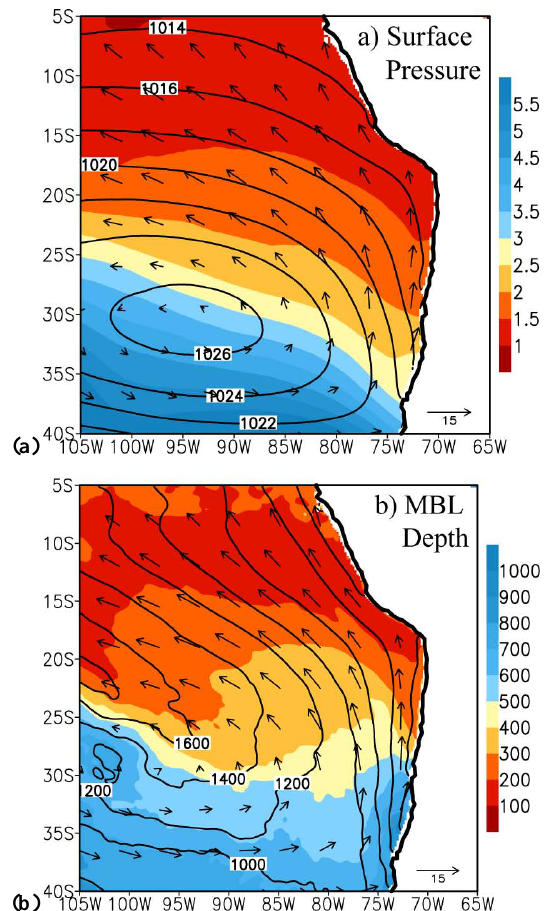
Fig. 5. (a) WRF-derived mean sea level pressure (hPa, contours), standard deviation of sea level pressure (hPa, color), and mean 10- m wind (ms − 1 , vectors). (b) WRF-derived mean MBL height (m, contours), standard deviation of MBL height (m, color), and mean wind at top of MBL (vectors,m s − 1 ) during October and November